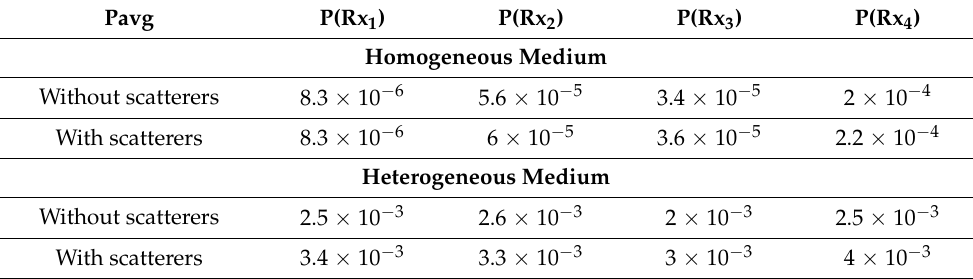
Table 4. Average received power in watts for multi-user WPT scenario.